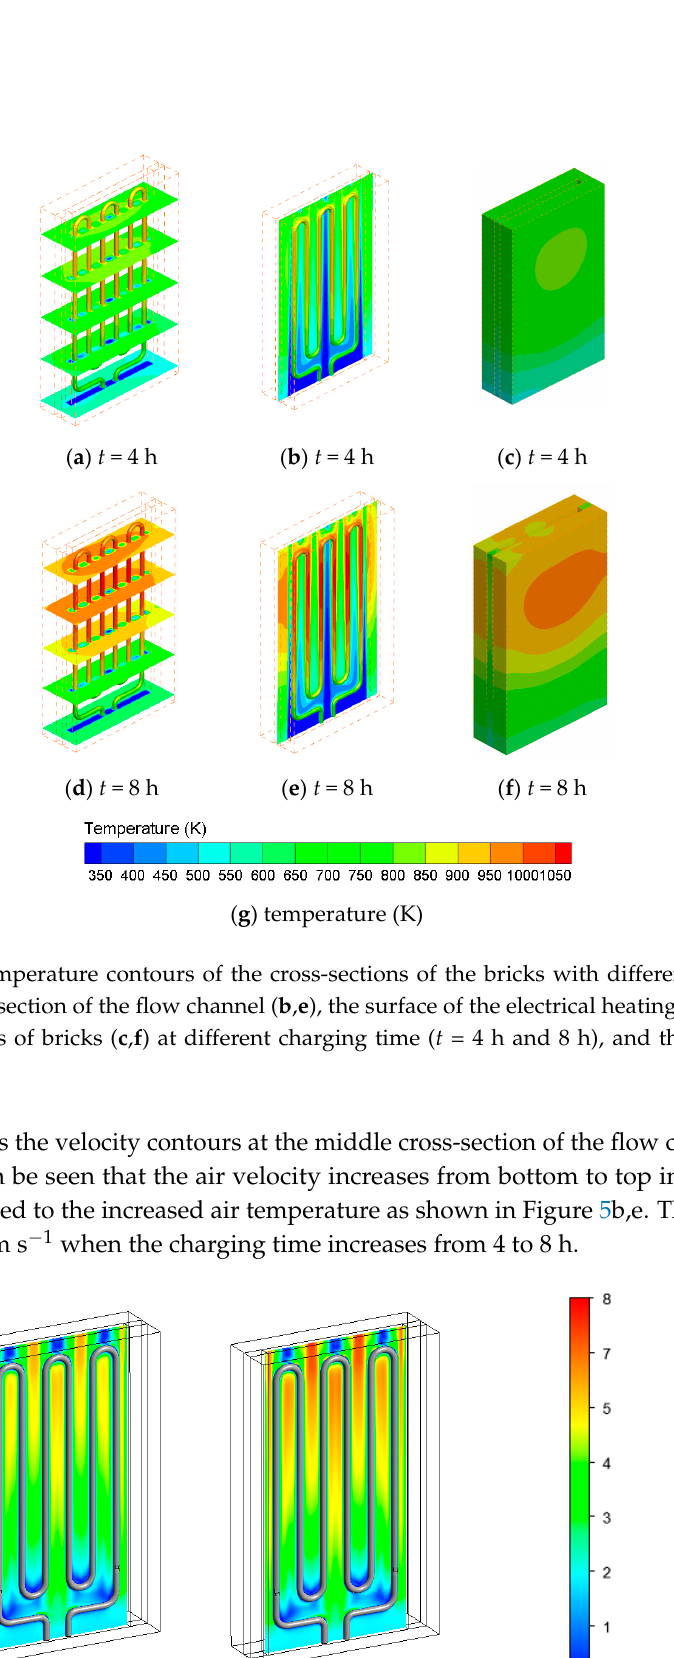
Figure 6. The velocity contour at the middle cross-section of the flow channel at different charging time.